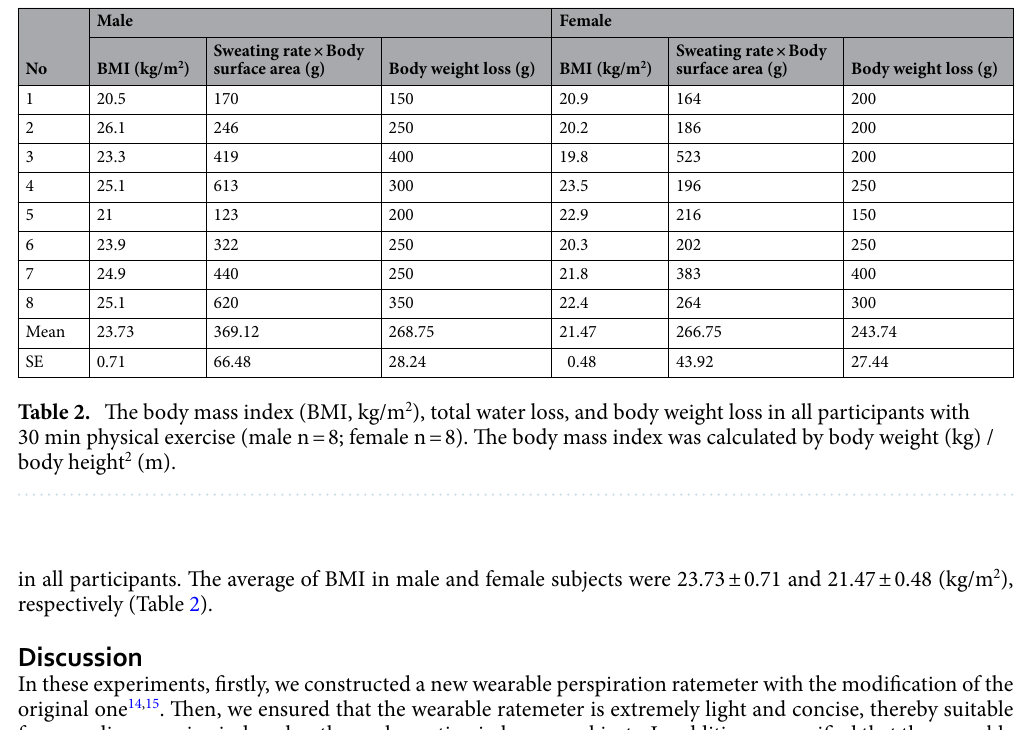
Sweating rate × Body surface area